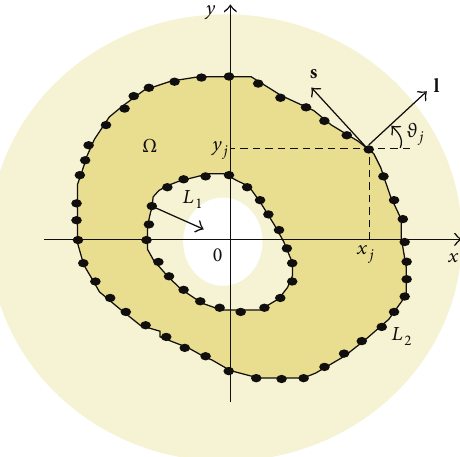
Figure 3: The considered doubly connected domain Ω